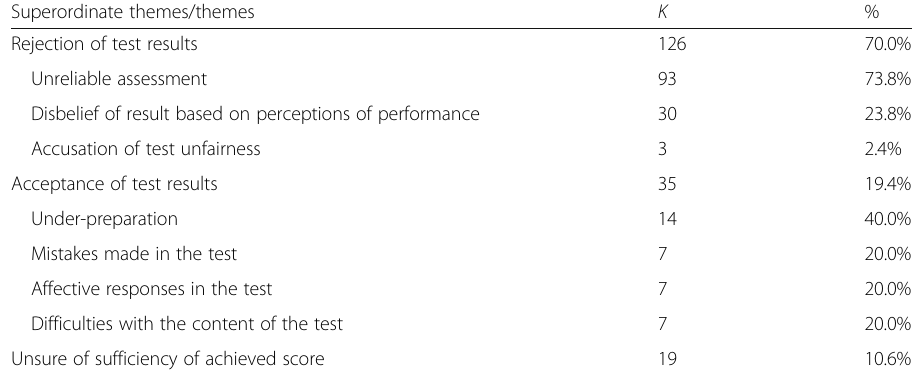
Table 5 Occurrences of perceptions held towards IELTS test results of underperforming candidates Superordinate